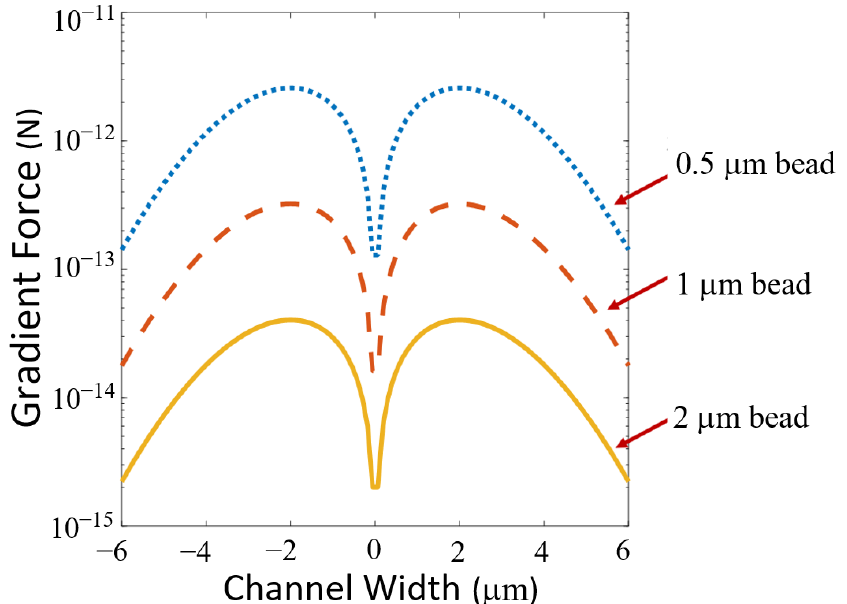
Figure 7. Gradient force versus channel position in the liquid channel for various particle diameters. The force intensity increases from the side wall as it approaches the center. The change in the force is relatively low in the center where the power is the highest and is evenly distributed.